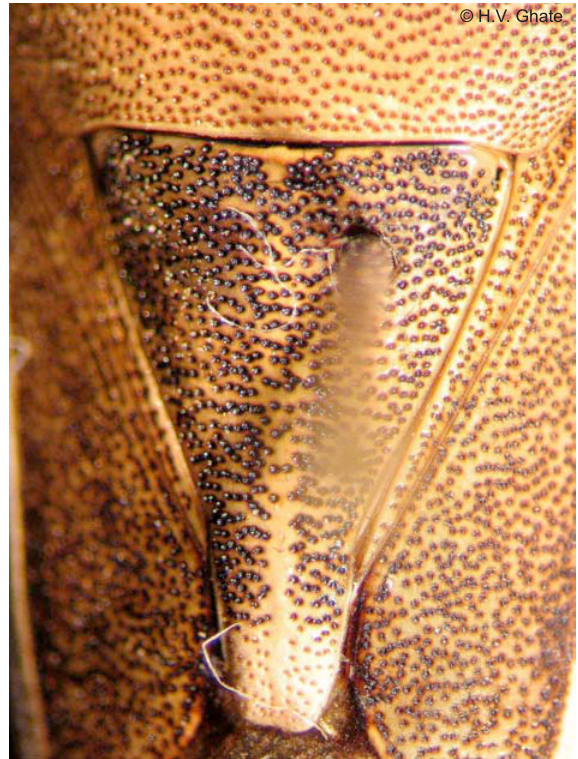
Image 4. Andrallus spinidens : scutellum close up showing relatively dark coarse punctures in basal area and clear central line as well as an apical colorless area with punctures